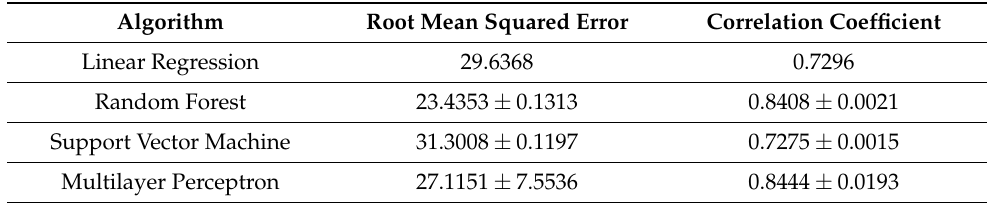
Table 5. Results (mean ± SD) obtained by the algorithms.